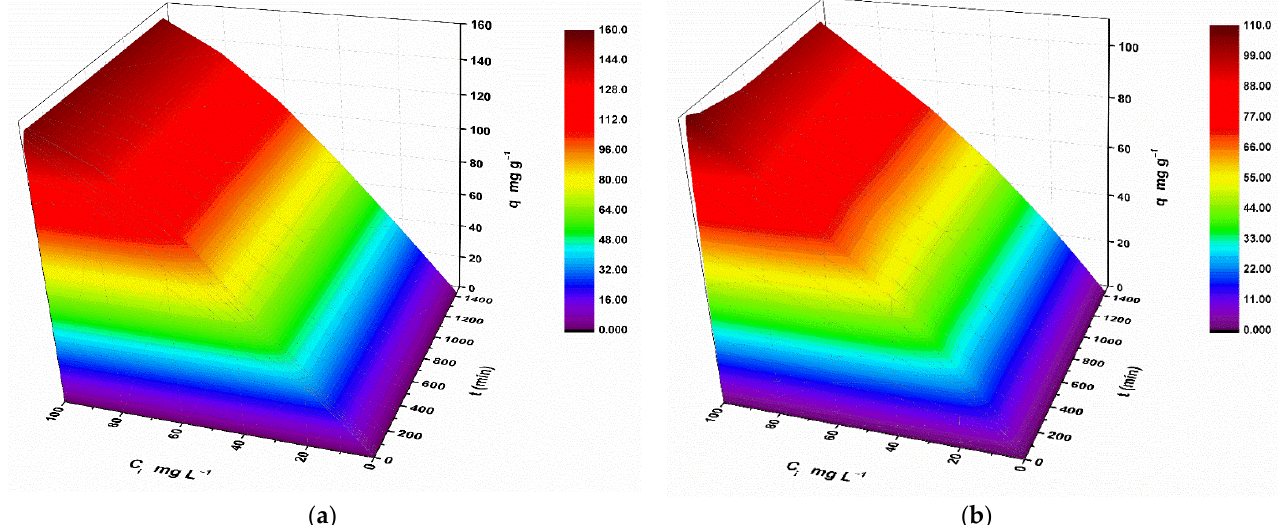
Figure 9. The 3D adsorption models of combined effects of variables on ( a ) Pb and ( b ) Cd adsorption capacity of CHIT-PAAA.